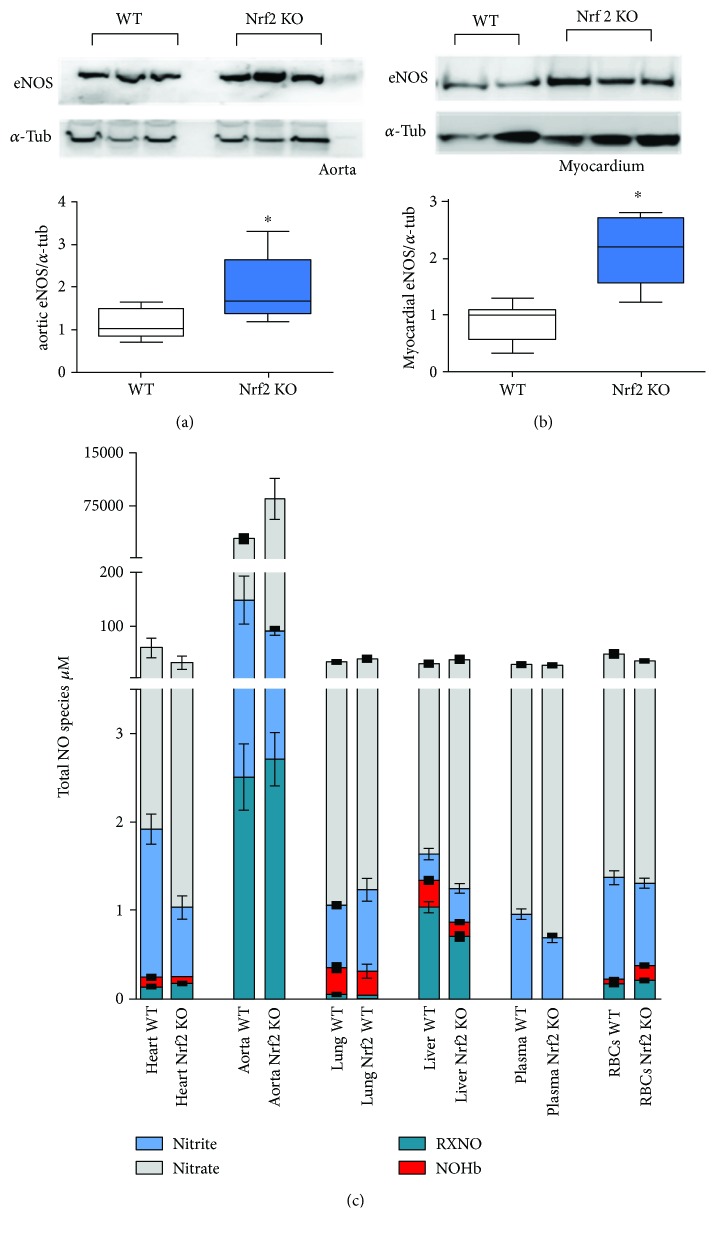
Upregulation of eNOS and preserved total levels of NO metabolites in Nrf2 KO mice. (a) Representative Western blot of eNOS (upper panel) standardized to alpha-tubulin (lower panel) and densitometric analysis of eNOS expression in aorta and (b) heart of WT and Nrf2 KO mice detected by Western blot (n = 5 per group, means ± quartiles, ∗
p < 0.05, t-test). (c) Total NO species in different tissues of Nrf2 KO and WT mice (n = 5 per group, means ± SEM), (for statistical comparisons and SD please refer also to Table 2).